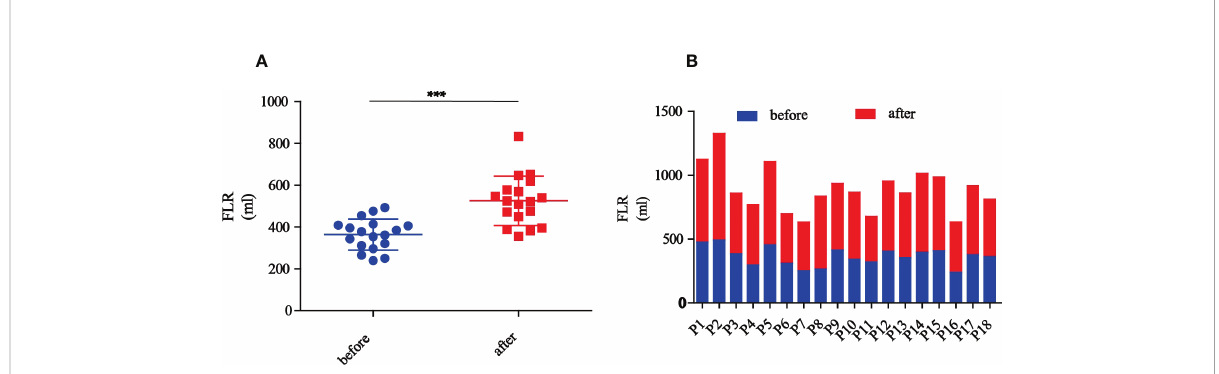
FIGURE 2 The changes of FLR before and after PMA and PVE. (A) The overview of FLR changes in all patients before and after PMA and PVE (*** represent p<0.001). (B) Each patient ’ s FLR changes before and after PMA and PVE.